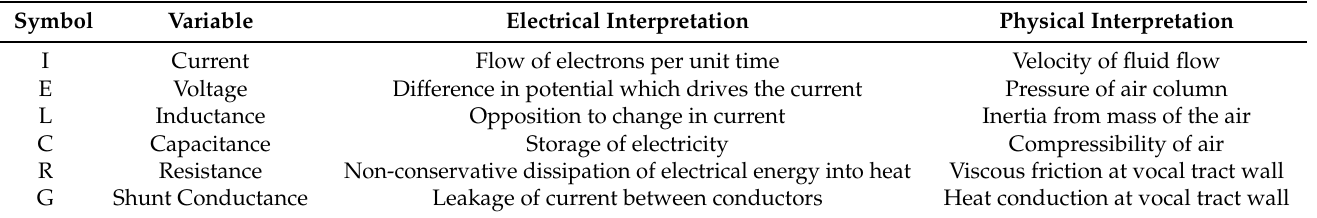
Table 1. Electrical equivalences to vocal tract properties.